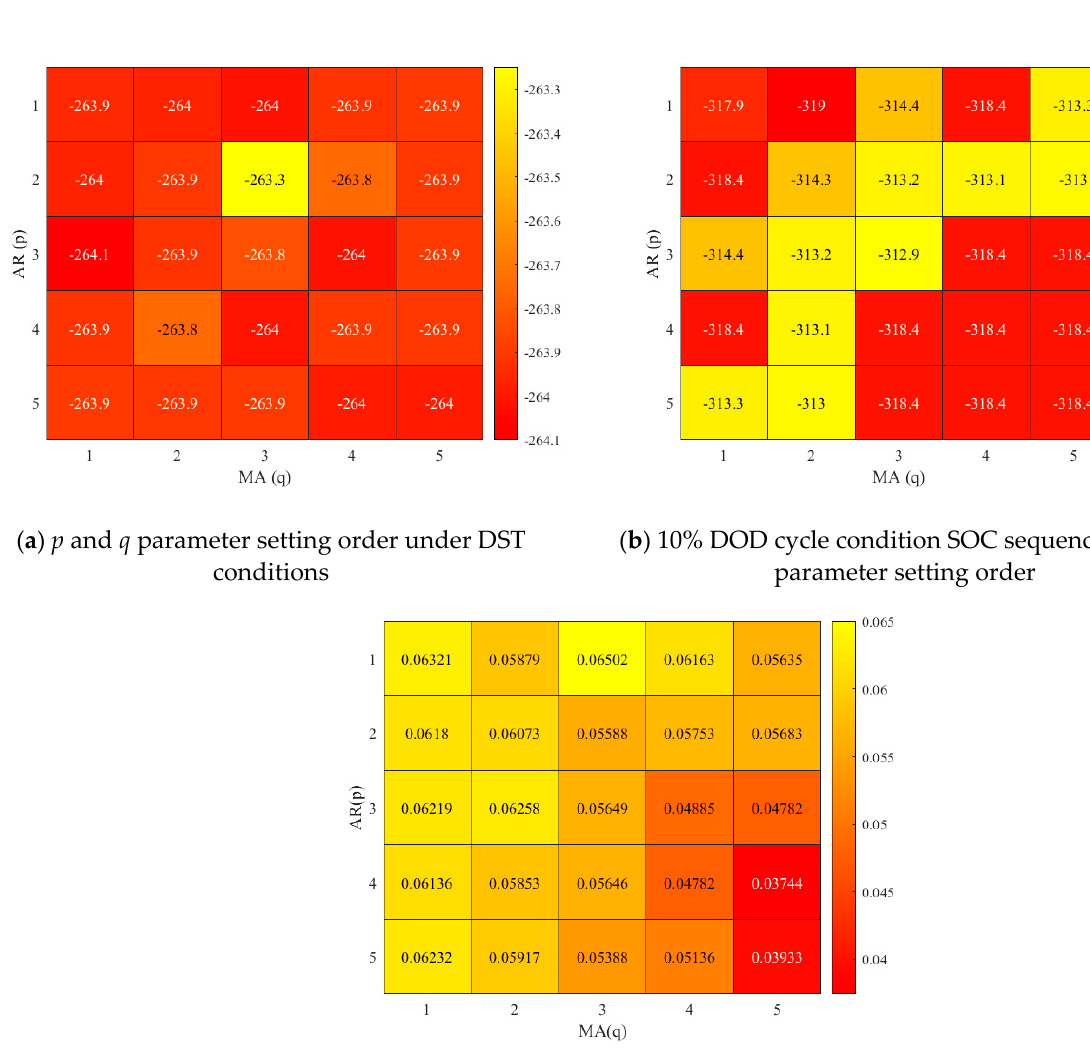
Figure 7. Akaike information criterion (AIC) criteria for parameter selection.